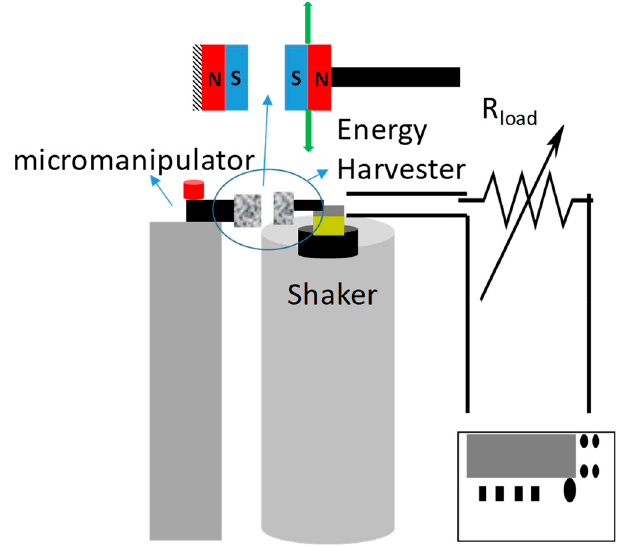
Figure 3. Schematic of the testing setup with a vibration shaker and energy harvester connected to a variable load resistor and oscilloscope. The tethered magnetic sample is connected to a micromanipulator to control spacing between magnets.